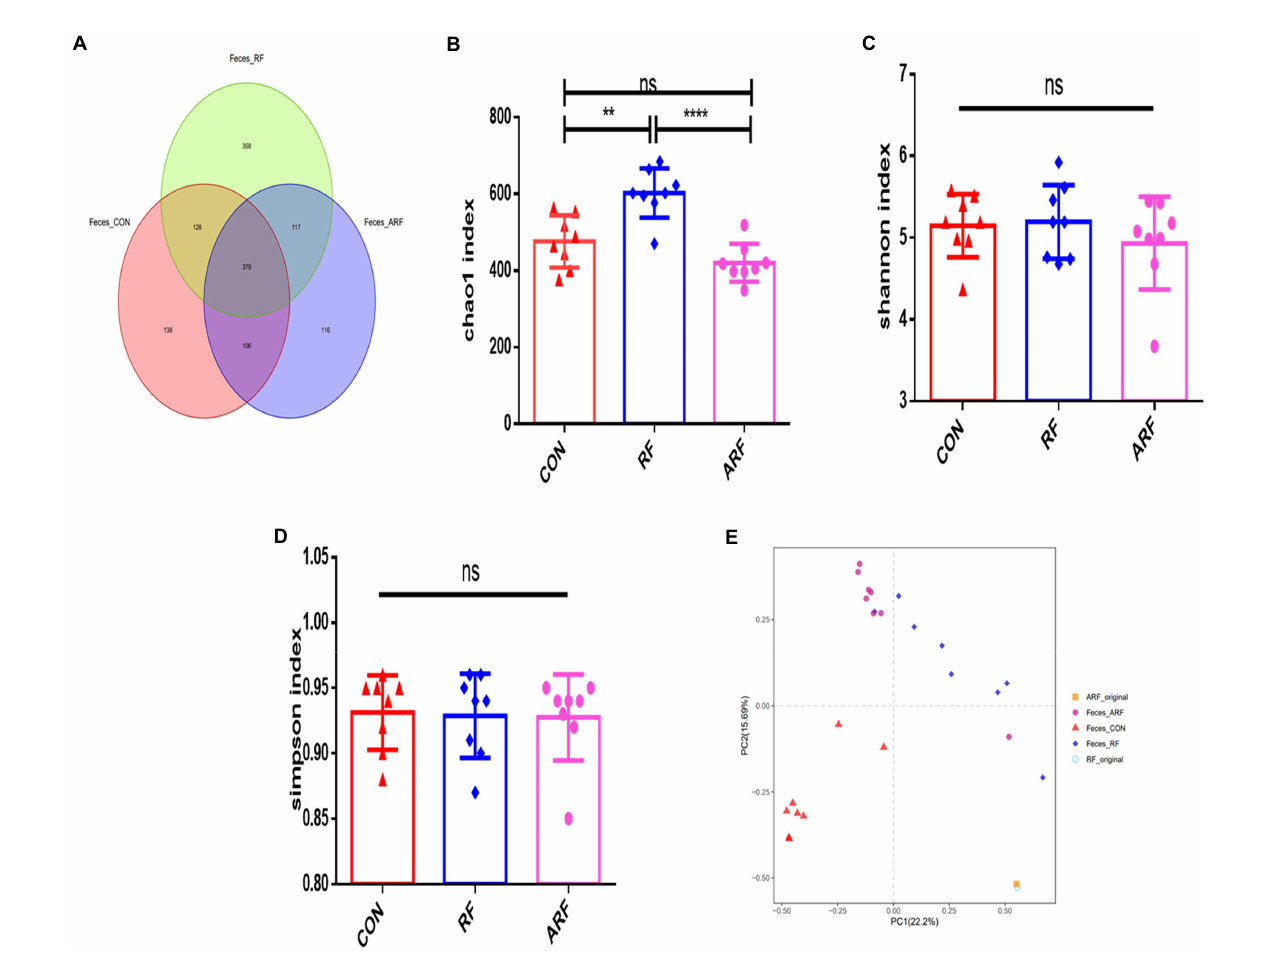
FIGURE 2 Gut Microbiota diversity analysis in 15-day old lambs after inoculation with ruminal fluid or autoclaved ruminal fluid. (A) Unique and shared intestinal operational taxonomic units (OTUs) for each group are shown in the Venn diagram. Alpha diversity (Chao1index, Shannon index, Simpson index) (B–D) ; beta diversity indicated by principal component analysis (PCA) plot (E) . Data are presented as means ± SD. n = 8, ** p < 0.01, **** p < 0.0001, ns indicates no